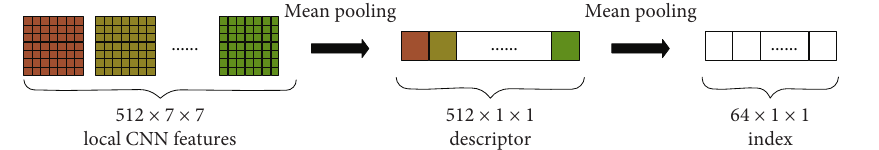
Figure 3: The process of feature encoding.